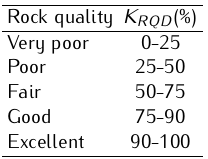
Table 8. Relationship between γ